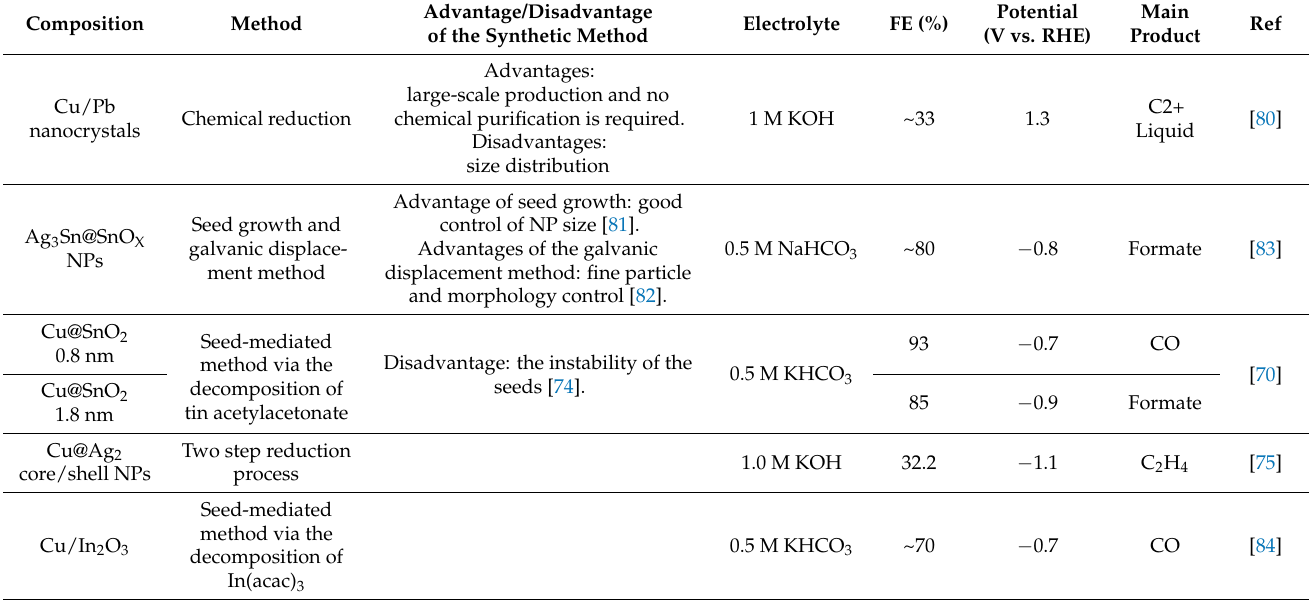
Table 4. Comparison of core/shell-based systems for CO 2 RR.